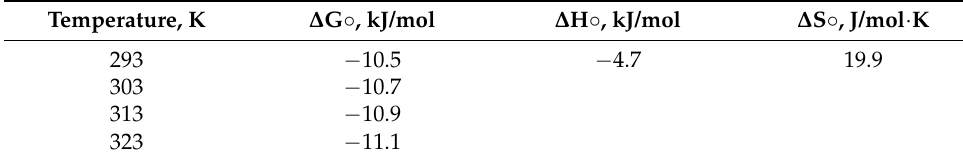
− 11.1 Negative values of ∆ G ◦ indicate spontaneous adsorption and the degree of spontaneity of the reaction increases with increasing temperature. The negative charge ∆ H ◦ indicate the exothermic character of the sorption, while the positive ∆ S ◦ reflects the affinity of the biosorbent toward